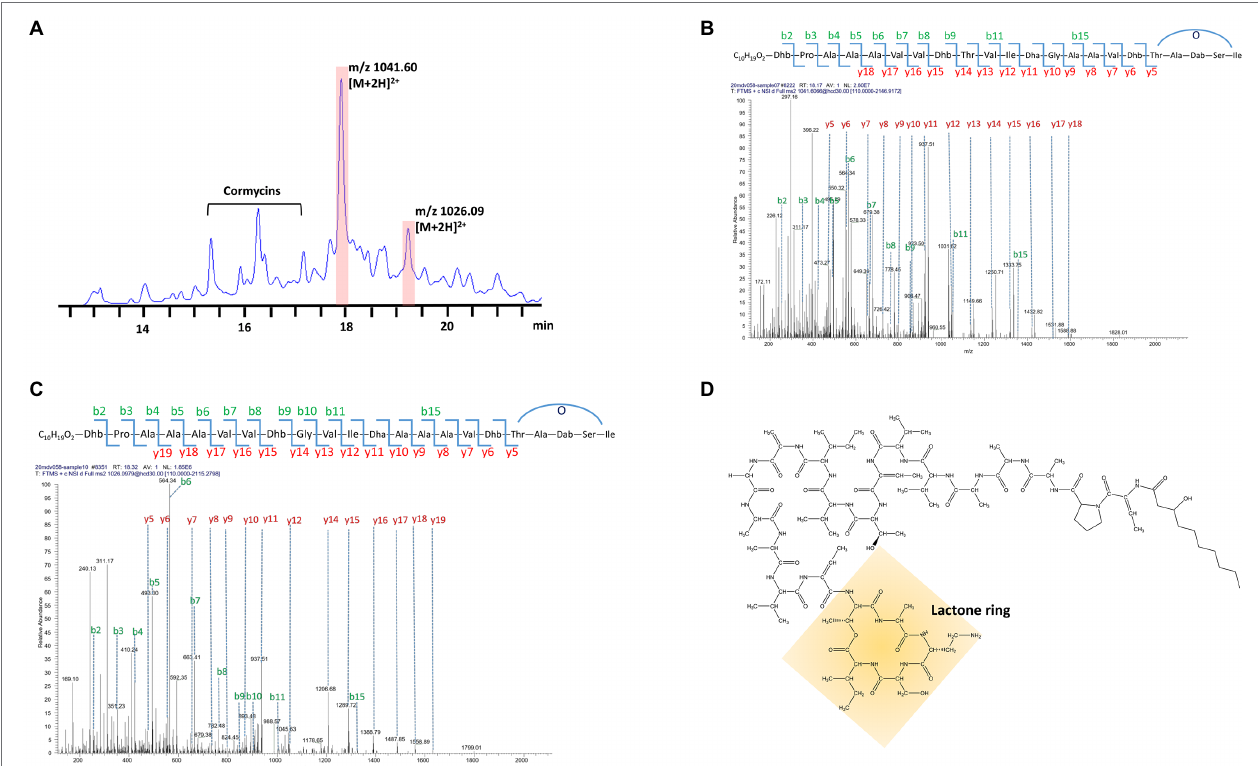
FIGURE 1 | Characterization of Purified CLPs produced by strain EDOX. (A) HPLC chromatographic profile of crude extract from supernatant of strain EDOX. (B) De novo sequencing of medipeptin A (m/z 2082.20) predicted from gene cluster 3 obtained by genome mining of P. mediterranea EDX by using